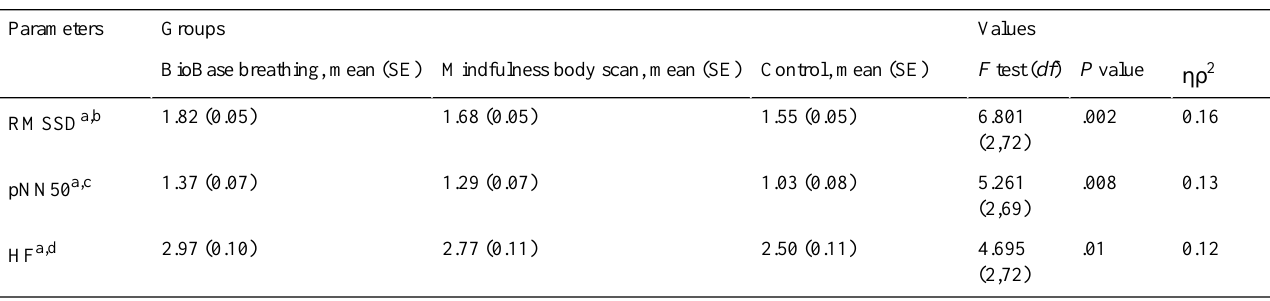
Table 2. Group means, standard deviations, between-group F ratio and effect sizes in the BioBase breathing, mindfulness body scan, and control group during poststress